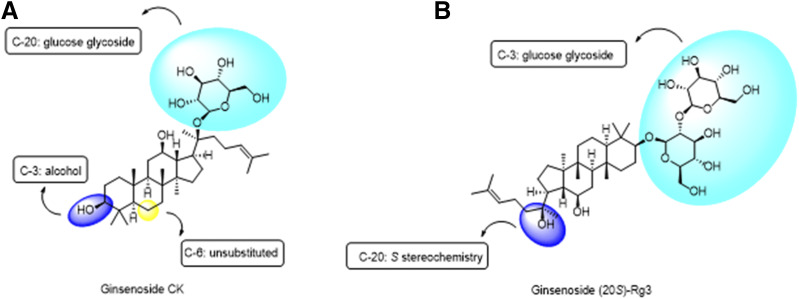
Proposed structure-activity relationship for glycosides acting as PAMs at P2X7. (A) The chemical structure of ginsenoside-CK is shown with important groups highlighted. Glucose attachment (cyan) is critical for activity at P2X7. C-6 substitutions are not tolerated (yellow). (B) The chemical structure of ginsenoside-20(S)-Rg3 is demonstrated with positioning relative to the P2X7 binding mode (inverted). The C-3 glucose attachments (cyan) face up into the binding pocket. The C-20 hydroxyl group shows that stereochemistry and positioning are critical for activity at P2X7.